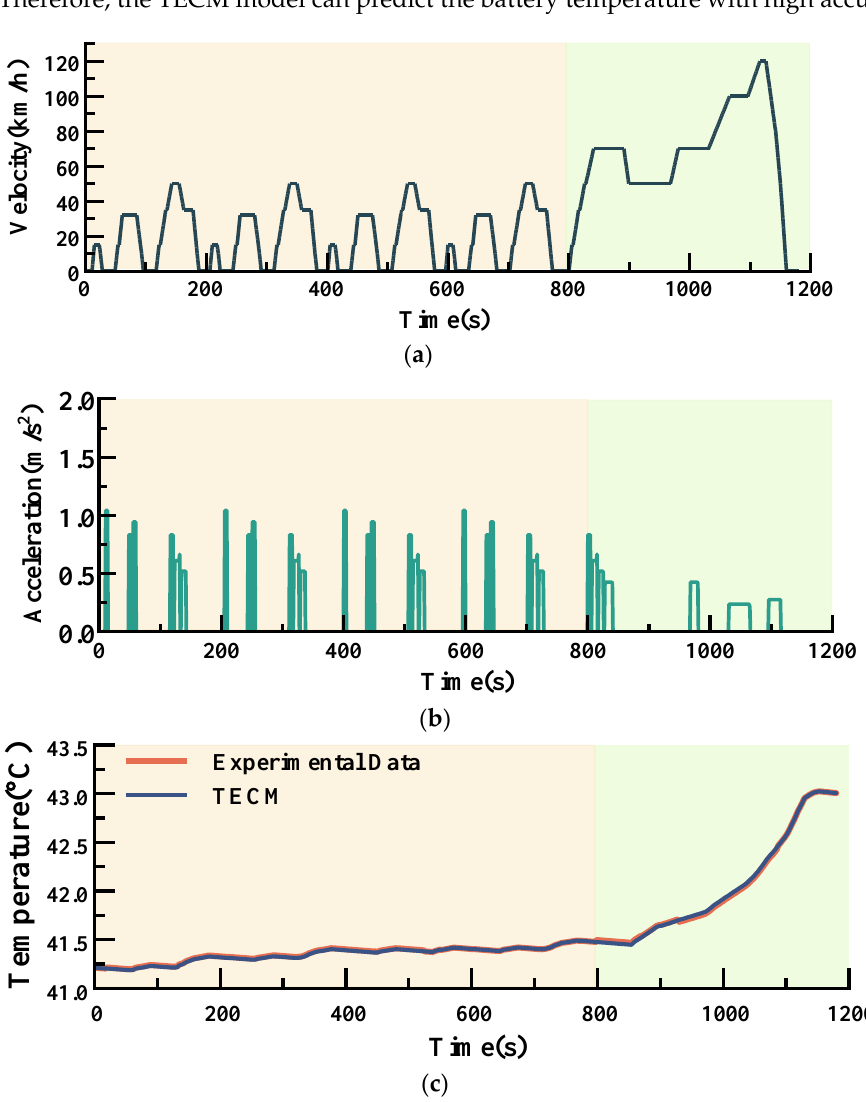
Figure 13. NEDC ( a ) velocity, ( b ) acceleration and ( c ) temperature compared between TECM and experimental data.